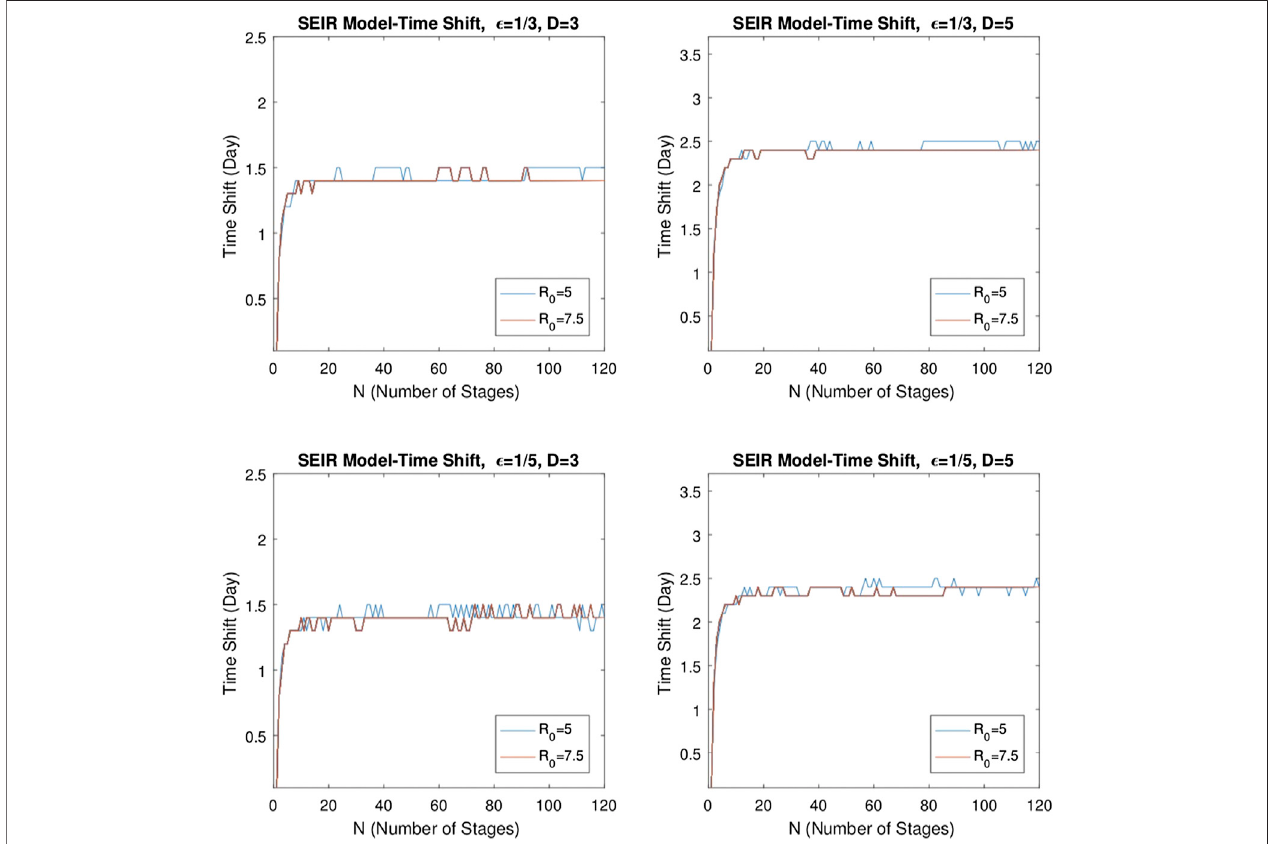
FIGURE 12 | Variation of time shift for R 0 (cid:2) 5 and 7.5 in the multistage SEIR model. Here, ϵ (cid:2) 1 / 3 , 1 / 5, and D (cid:2) 3 , 5 are taken. For each case, delay becomes stable at a constant value after a critical stage number N .